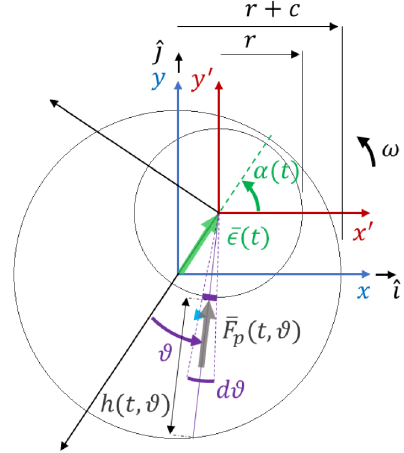
Fig. 4. Graphical problem statement and de fi nition of the reference frames for the bearing hydro-dynamic model.